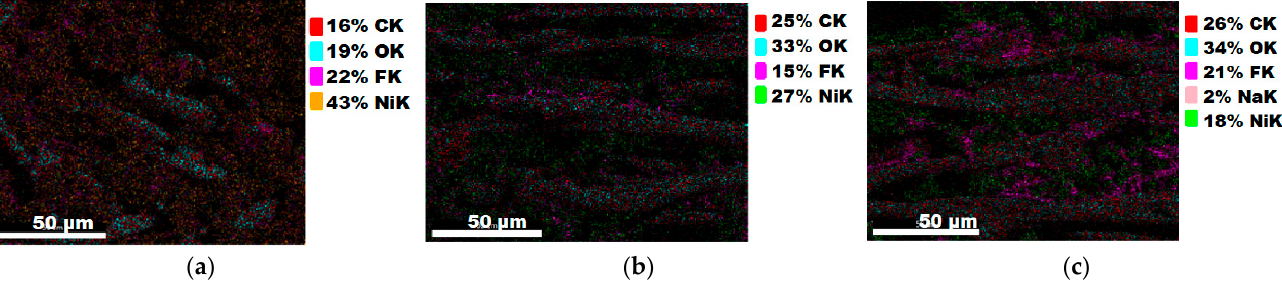
Figure 7. Smart elemental mapping overlay for sample 3: ( a ) untreated with artificial perspiration;